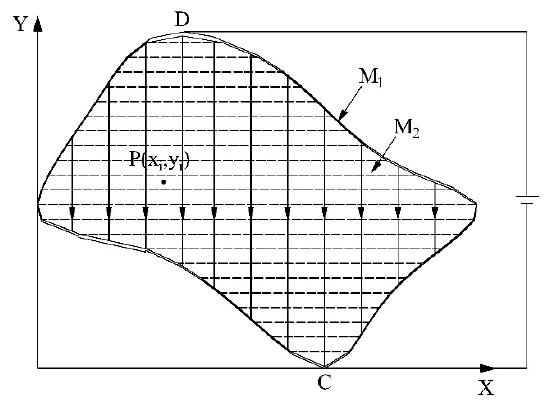
Figure 8. Y-axis detecting principle.